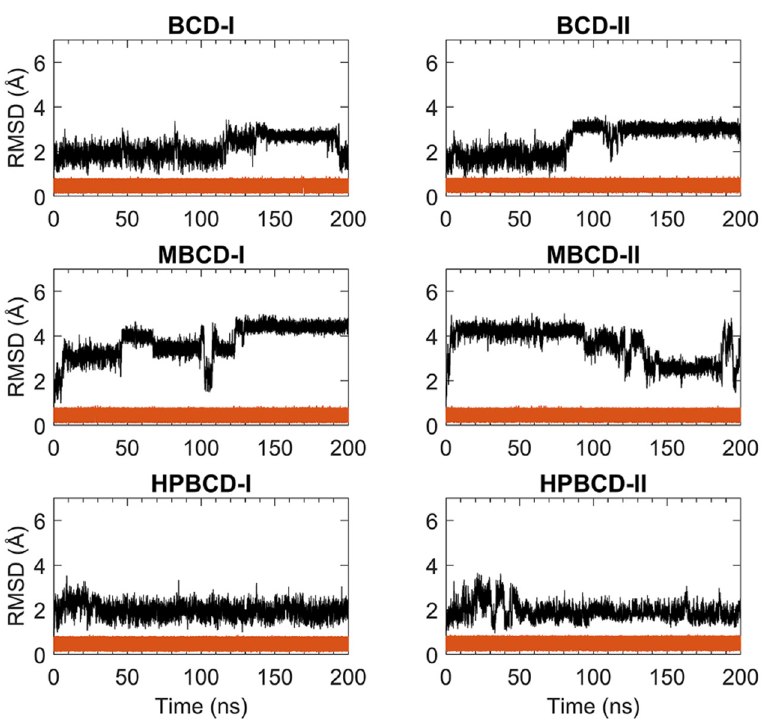
Figure 1. RMSD plots of plumbagin and BCDs during 200 ns MD simulations. The red and black lines represent the RMSD of plumbagin and BCDs, respectively.